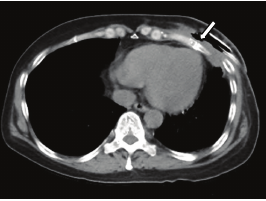
Figure 4: Computed tomography showing that the abscess cavity has shrunk and that the fracture in the fifth rib has healed